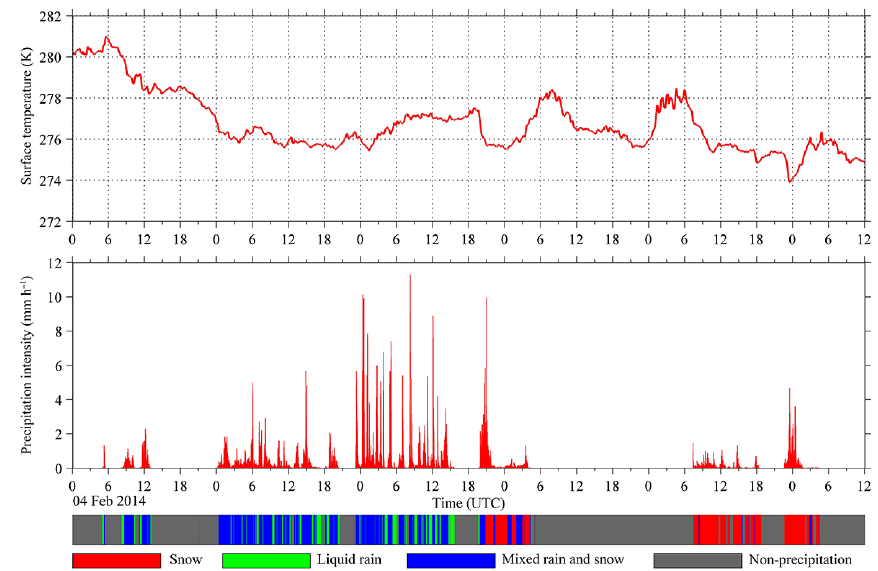
Figure 5. The time series of surface temperature measured by MWR, and precipitation intensity and precipitation type measured by the disdrometer from 00:00UTC on 4 February 2014 to 12:00UTC on 9 February 2014.